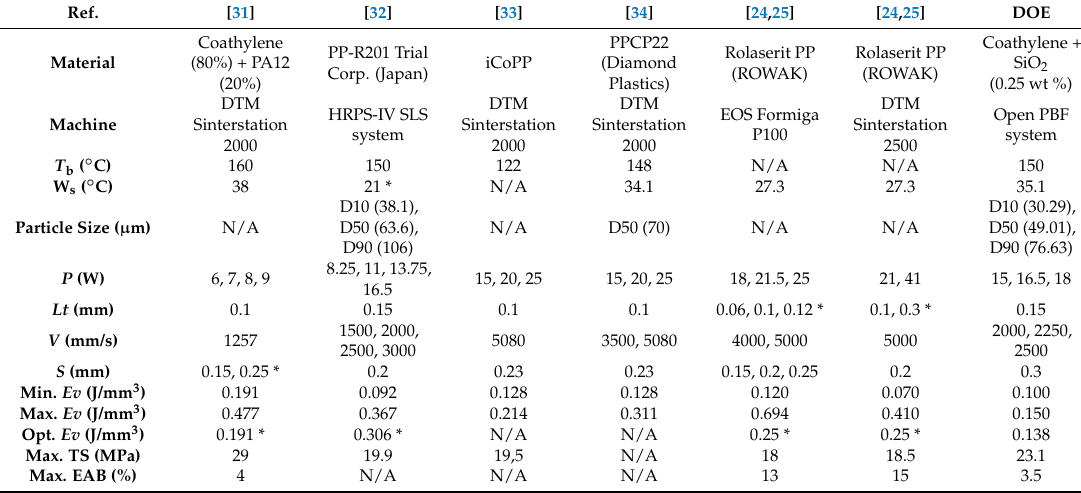
Table 3. Literature research for process parameters window and mechanical performance for PBF of polypropylene